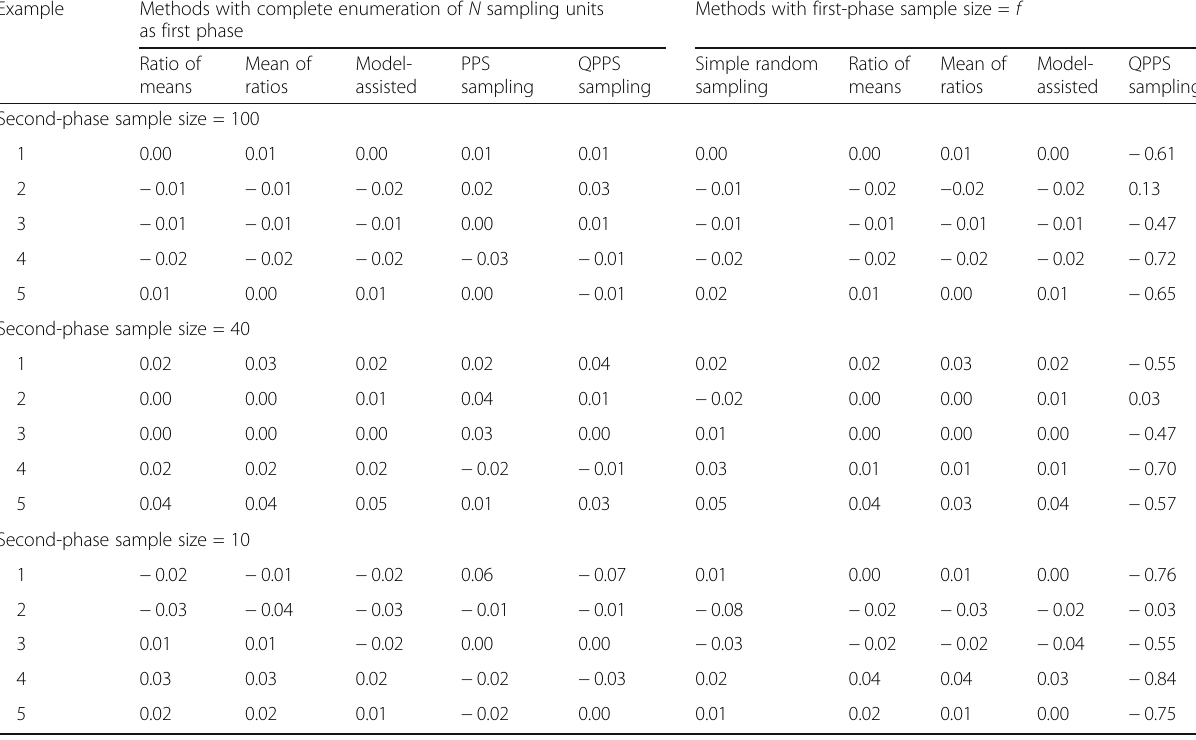
Table 2 Bias (%) in estimates of the population mean from simulations of inventory in five example populations